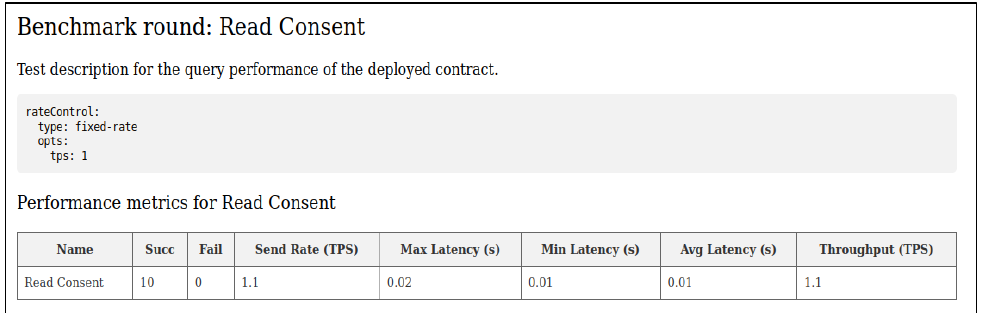
Figure 16. Caliper results (Create consent) of experiment 1.